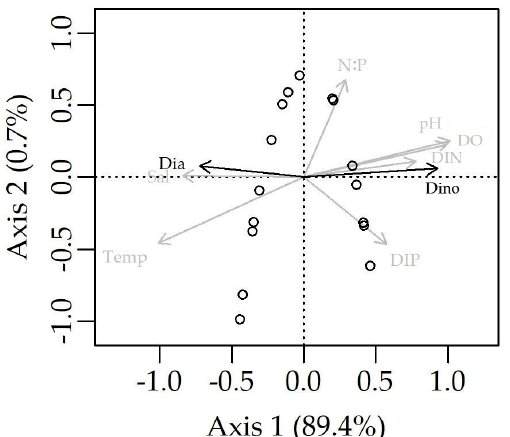
Figure 5. Redundancy analysis (RDA) of cell densities of dinoflagellates and diatoms and environmental drivers in the surface water of the Taiwan Strait during the cruises in May and July 2019. Dino and Dia represent cell density of dinoflagellate and diatom, respectively. Temp: temperature, Sal: salinity, DO: measured dissolved oxygen concentration, DIN: dissolved inorganic nitrogen, DIP: dissolved inorganic phosphorus, N:P DIN:DIP ratio. Hollow points represent the scores for each